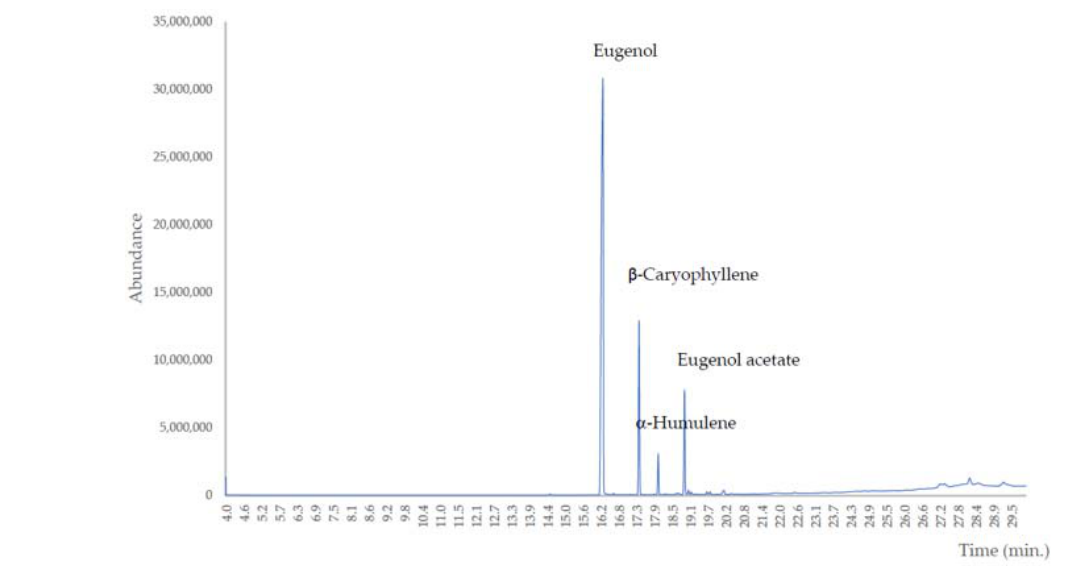
Figure 2. GC–MS chromatogram of CEO. Table 2. The activity data of CEO and EUG expressed as a range of MIC (minimal inhibitory concentration) or MFC (minimal fungicidal concentration) [mg/mL] and MFC/MIC ratio against the reference strains of Candida spp.